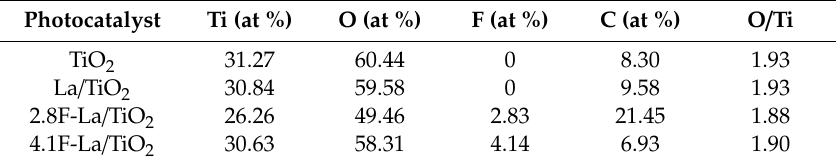
Table 4. Surface concentration of surface fluorine and lattice fluorine determined by XPS.